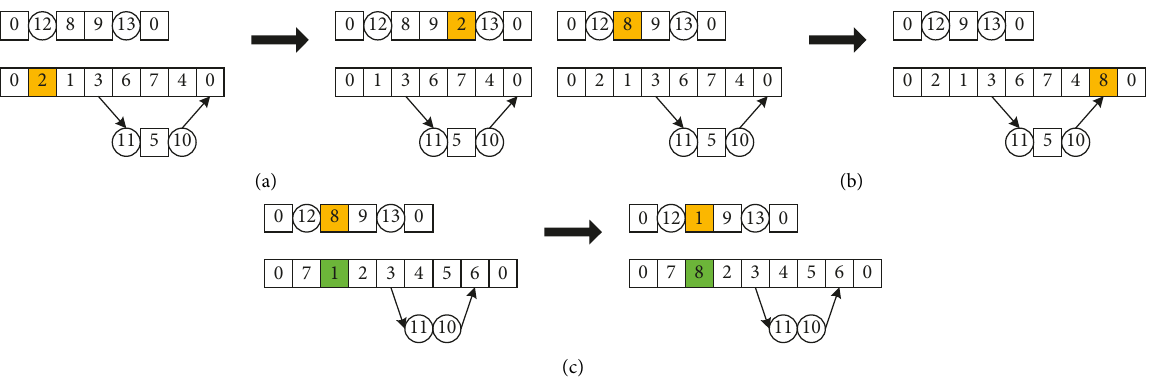
Figure 7: Examples of the interchange operators for one main tour (or truck route) and one UV route.